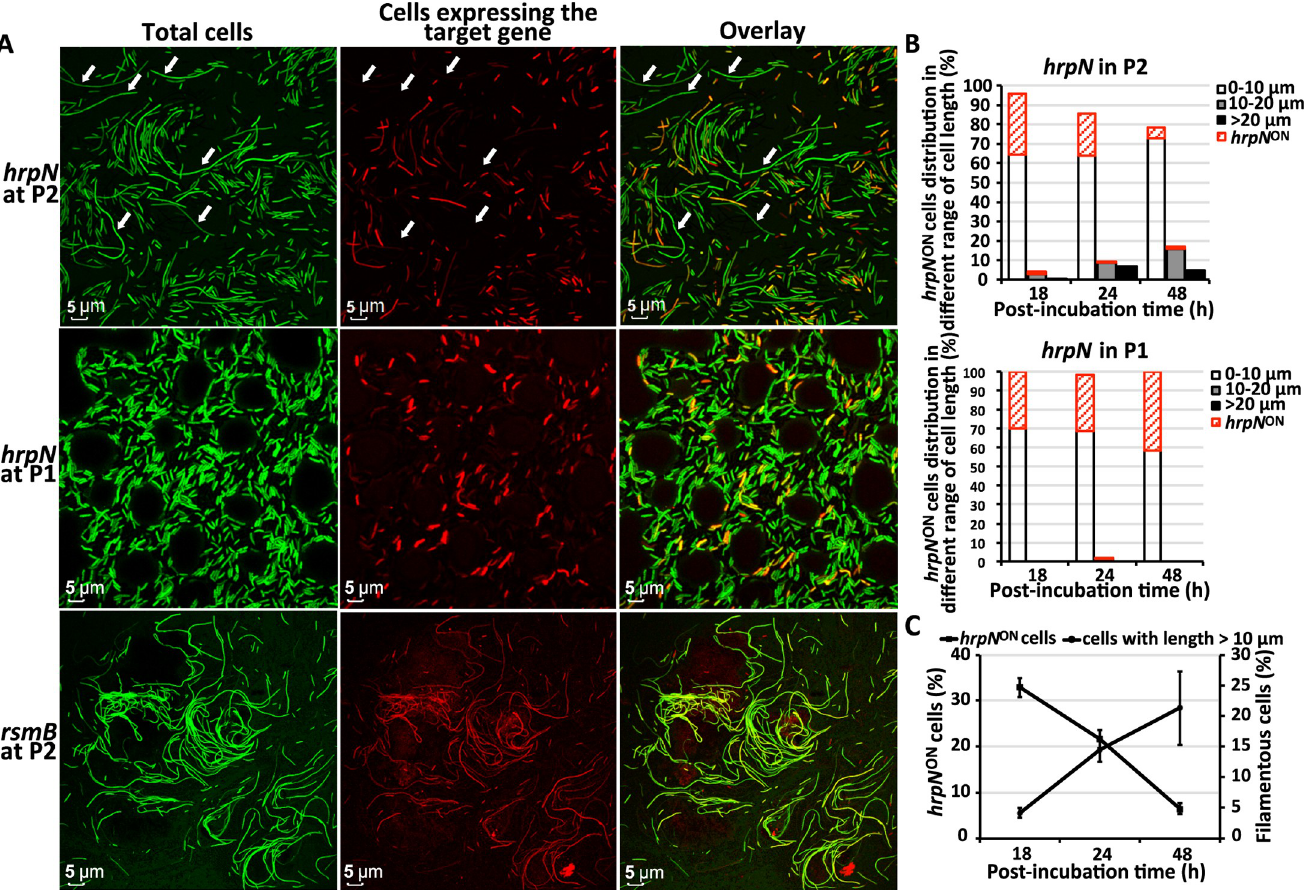
Fig 4. Expression of the T3SS gene hrpN in filamentous and short cells of D . dadantii on potato tuber. (A) Visualization of hrpN -expressing cells ( hrpN ON cells) in filamentous and short cells of D . dadantii on potato tuber. D . dadantii carrying a hrpN-mCherry-nptII-gfp was inoculated onto potato tuber in the absence of freestanding water for 48 h. Potato tissues collected at P1 and P2 positions were observed under confocal microscope. Total bacterial cells were visualized by green fluorescence and hrpN ON cells were visualized by red fluorescence. The expression of a non-T3SS gene rsmB (through a rsmB-mCherry-nptII-gfp construct) was used as a control. (B) Percentage of the hrpN ON cells in filamentous and short cells. At each time point (18, 24 and 48 hpi), total D . dadantii cells were categorized into three groups based on their cell length (0–10 μ m, 10–20 μ m and > 20 μ m). The proportion of hrpN ON cells within each group is highlighted in red. (C) Correlation between the percentage of hrpN ON cells and the percentage of filamentous cells at P2 position at 18, 24, and 48 hpi. The experiments were repeated three times with similar results.